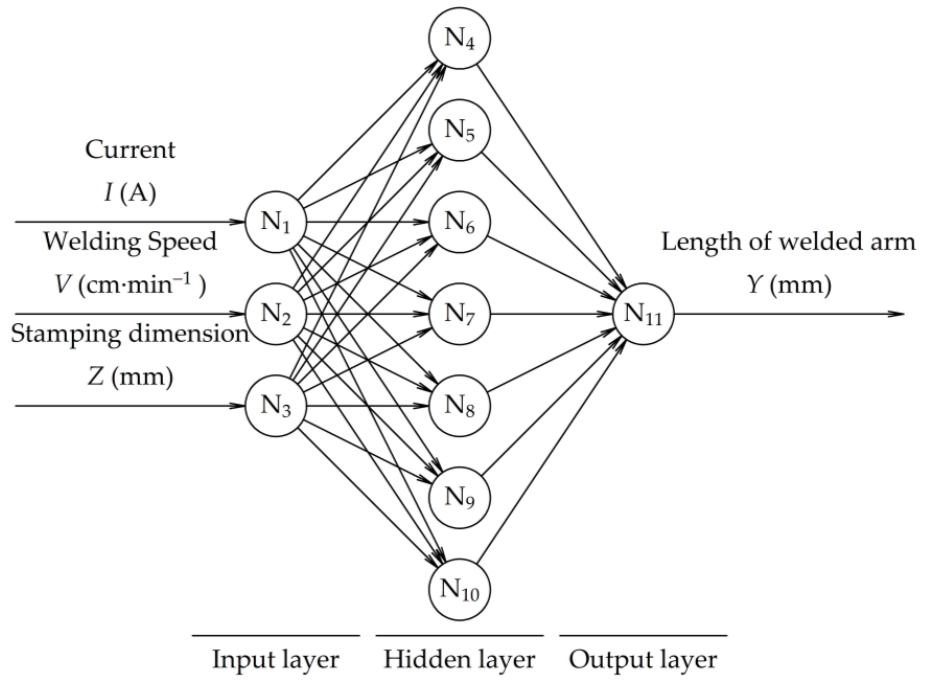
Figure 7. The main structure of ANN.